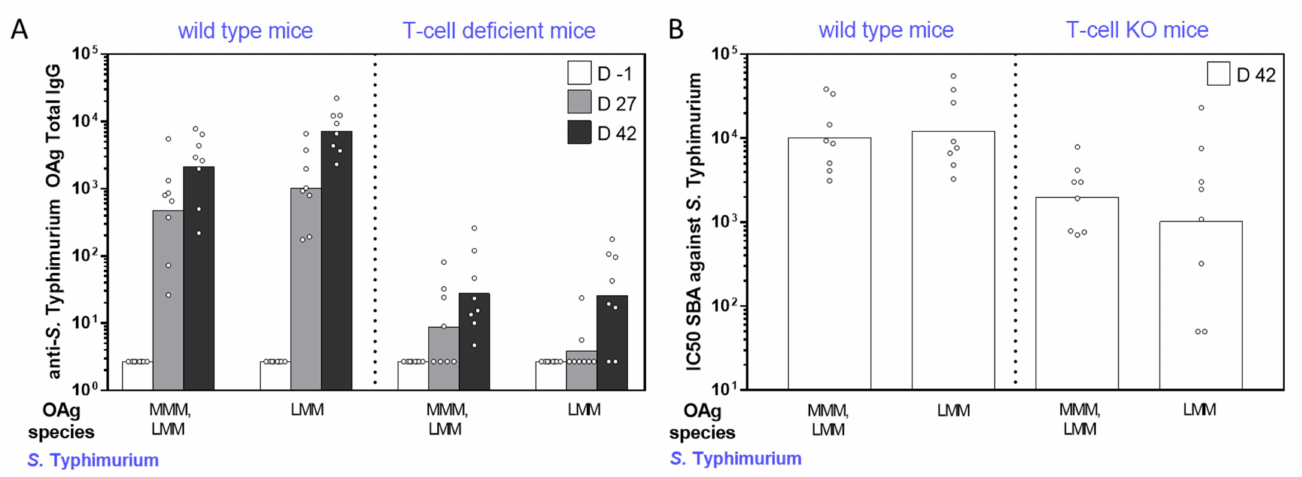
Figure 4. Immunogenicity in mice of S. Typhimurium GMMA differing for sugar length. Eight wild-type (CD1) and T-cell-deficient mice (nude CD1) per group were subcutaneously immunized on days 0 and 28, with 0.5 µ g OAg dose. ( A ) Summary graphs of anti-OAg specific IgG reporting individual antibody levels (dots) and geometric mean with 95% confidence interval (bars). ( B ) Summary graph of SBA titers against S. Typhimurium reporting individual IC50 levels (dots) and geometric mean